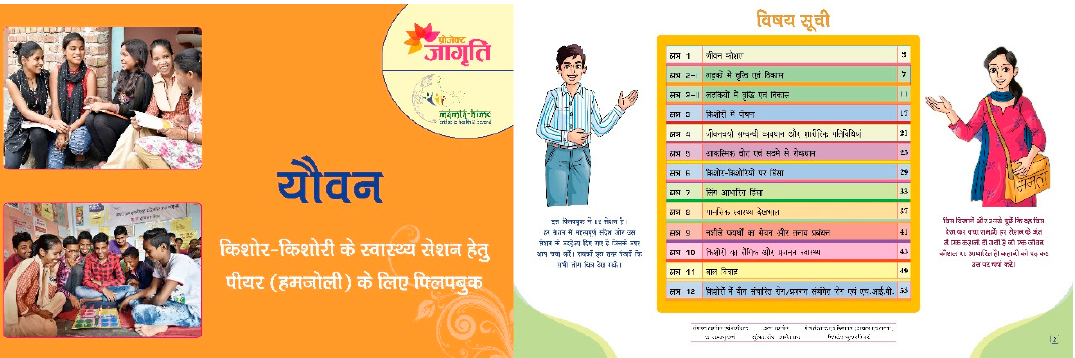
Figure 1. The cover page and the table of contents page in the flipbook for adolescents (“ Yauvan